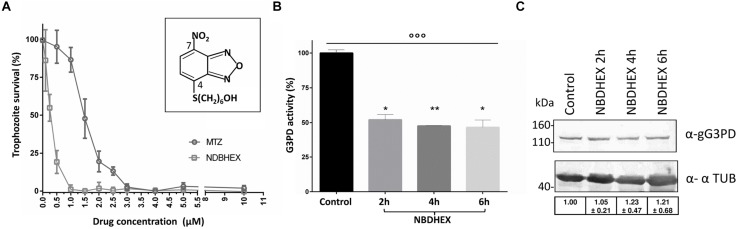
Evaluation of NBDHEX effects on G. duodenalis growth and gG3PD enzymatic activity. (A) Survival of G. duodenalis WBC6 trophozoites was determined by methylene blue colorimetric assay after 48 h of treatment with different concentrations, ranging from 0.05 to 10 μM, of NBDHEX (empty dots) or metronidazole (MTZ, empty squares) in microaerophilic growth conditions. Data (mean percentage ± SD) represent three independent experiments, each done in triplicate. The structure of the NBDHEX compound is reported in the insert. (B) The FAD-glycerol-3-phosphate dehydrogenase activity was measured in protein extract (100 μg) from G. duodenalis trophozoites treated for the indicated times with 50 μM NBDHEX or for 6 h with ethanol (Control). The enzymatic activity of three independent experiments (mean ± SD) is expressed as the percentage change respect to the control. Unpaired t-test was performed between control and each time point (∗P < 0.05 and ∗∗P < 0.01). One-way ANOVA indicated statistically significant differences among all stages (°°∘P < 0.0001). (C) Twenty-microgram of protein extracts derived from trophozoites treated as described in (B), were separated on 4–12% SDS-PAGE and immunoblotted. A representative western blot analysis is shown and the antibodies indicated. Molecular size markers are reported in the left. Table in the bottom reports the densitometric analysis of three independent experiments (mean ± SD). Statistical analyses using t-test were not significant.